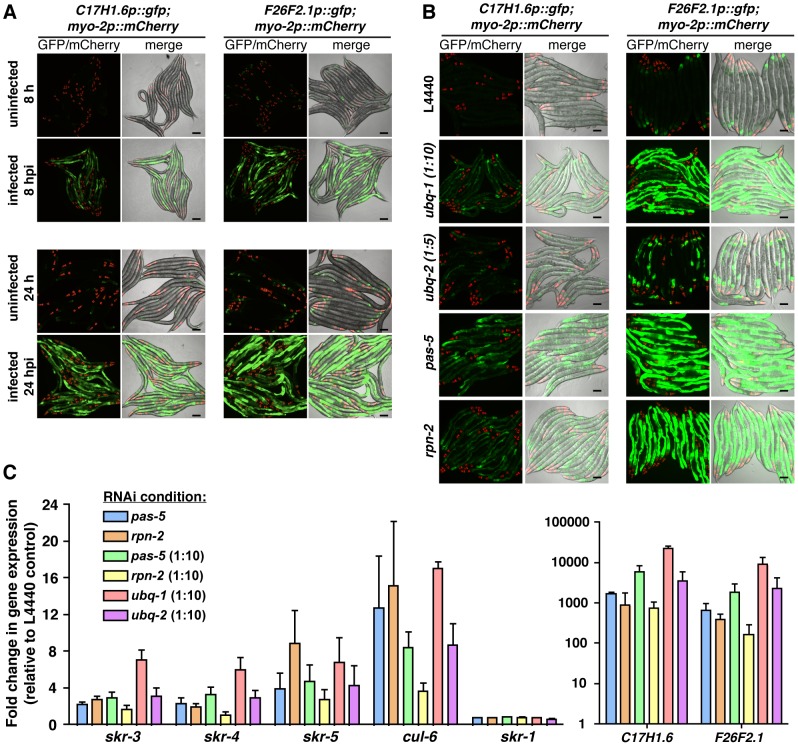
UPS perturbation induces similar gene expression responses to N. parisii infection.A) Expression of C17H1.6p::gfp and F26F2.1p::gfp in the intestine (pharyngeal myo-2p::mCherry expression is a marker for the presence of the transgene) following infection with N. parisii (8 and 24 hpi). Scale bars  = 100 µm. B) Expression of C17H1.6p::gfp and F26F2.1p::gfp following RNAi against ubq-1, ubq-2, pas-5 and rpn-2 in the absence of infection. C) Expression of endogenous mRNA of C17H1.6 and F26F2.1, as well as the SCF ligase components skr-1, skr-3, skr-4, skr-5 and cul-6 following RNAi against ubq-1, ubq-2, pas-5 and rpn-2 in the absence of infection, as assessed by qRT-PCR. Due to the very large changes in expression of C17H1.6 and F26F2.1 genes, these are presented on a separate graph to allow for expansion of the y-axis and easier observation of expression changes in SCF ligase components. Mean +/- SEM of two to three independent experiments.